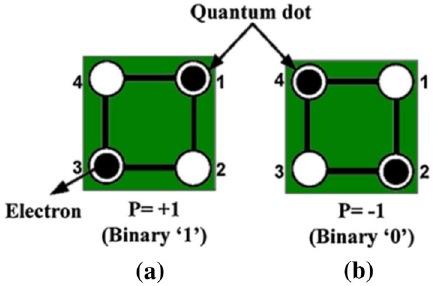
Fig. 1 The polarization of the QCA cell a P = + 1 and b P = − 1 [25]